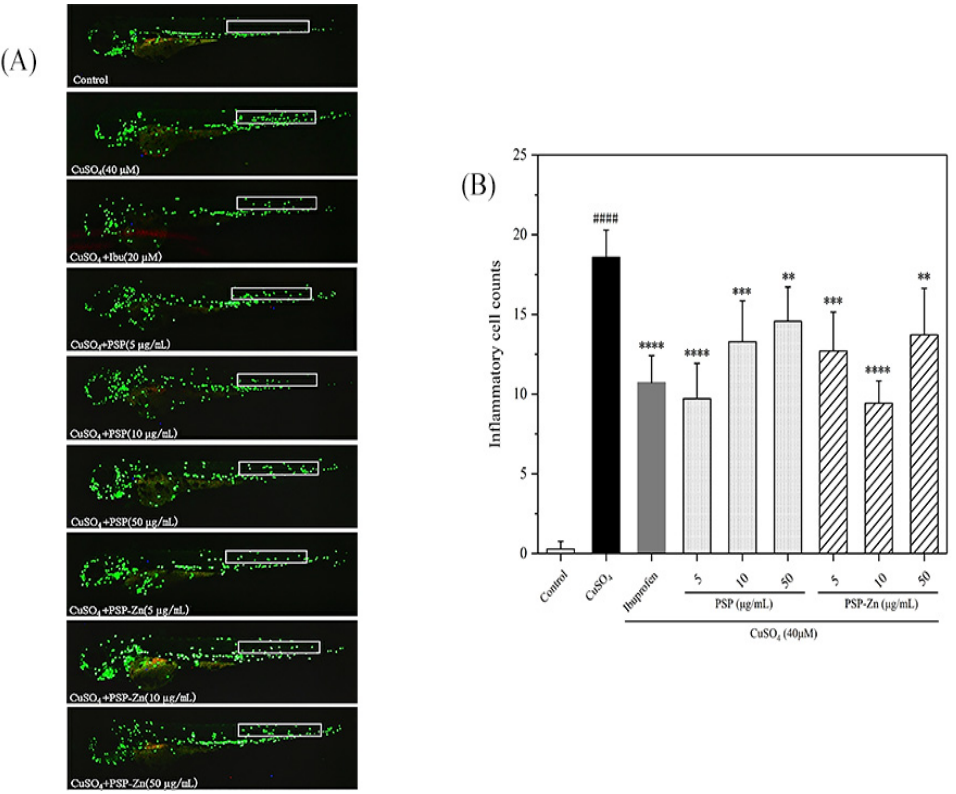
Figure 6. Anti-inflammatory activity of PSP and PSP − Zn in CuSO 4 -induced larvae. ( A ) In vivo representative fluorescence images of zebrafish macrophage migration. ( B ) Statistical results of the number of macrophage migrating in zebrafish lateral line (white square). Data are shown as mean ± SD with n = 7. #### p < 0.0001 as compared with the control group; ** p < 0.01, *** p < 0.001, and **** p < 0.0001 as compared with the model group.